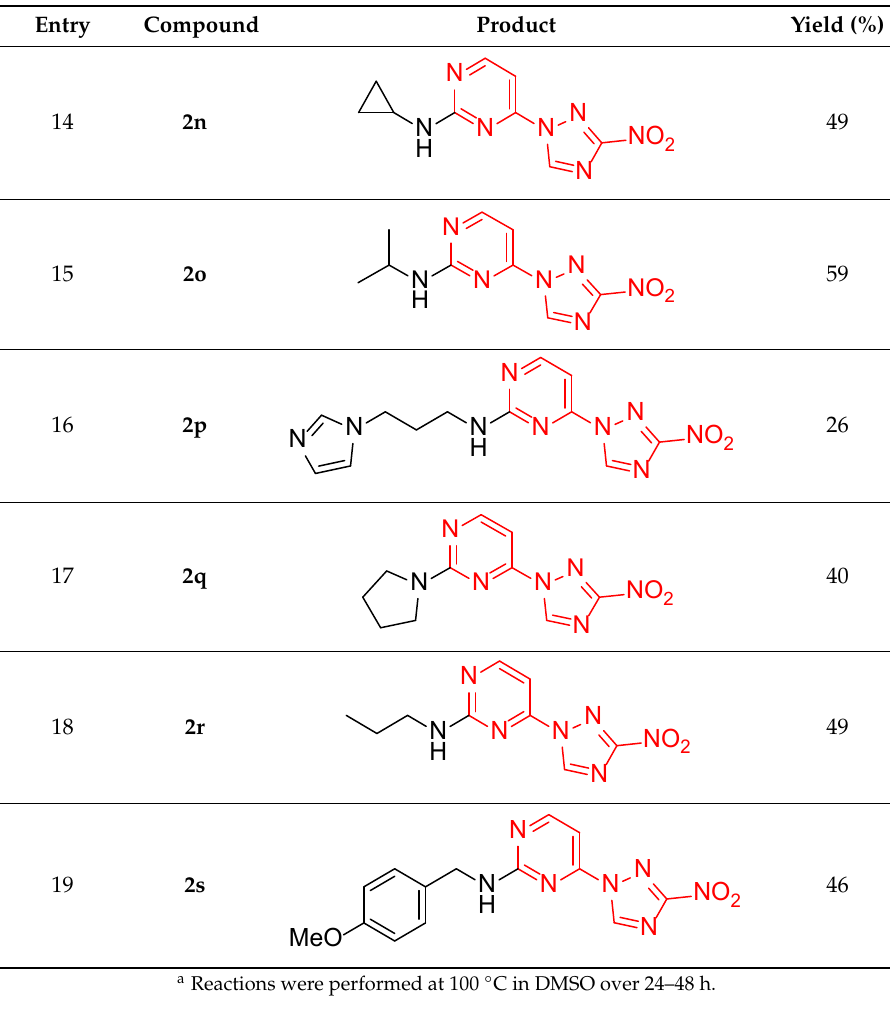
Figure 4. Single-crystal X-ray structures for compound 2h ( a , CCDC 1582450), 2k ( b , CCDC 1582440), 2n ( c , CCDC 1582442) and 2o ( d , CCDC 1582439); thermal ellipsoids are shown at 50% probability.